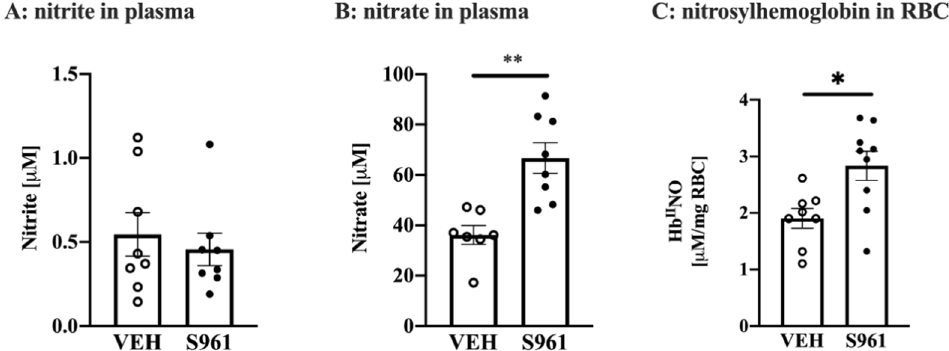
Figure 2. Effects of S961 treatment on plasma concentration of nitrite, nitrate and nitrosylhemoglobin content. Plasma concentration of ( A ): nitrite (VEH n = 8, S961 n = 8), ( B ): nitrate (VEH n = 7, S961 n = 8), ( C ): nitrosylhemoglobin (Hb II NO) content in red blood cells (RBC) (VEH n = 8, S961 n = 9). Statistical significance tested using two-sided Student’s t-test with Welch’s correction, normality confirmed by Shapiro–Wilk test, variance by F-test. Results shown as mean +/ − SE. * p < 0.05, ** p < 0.01.